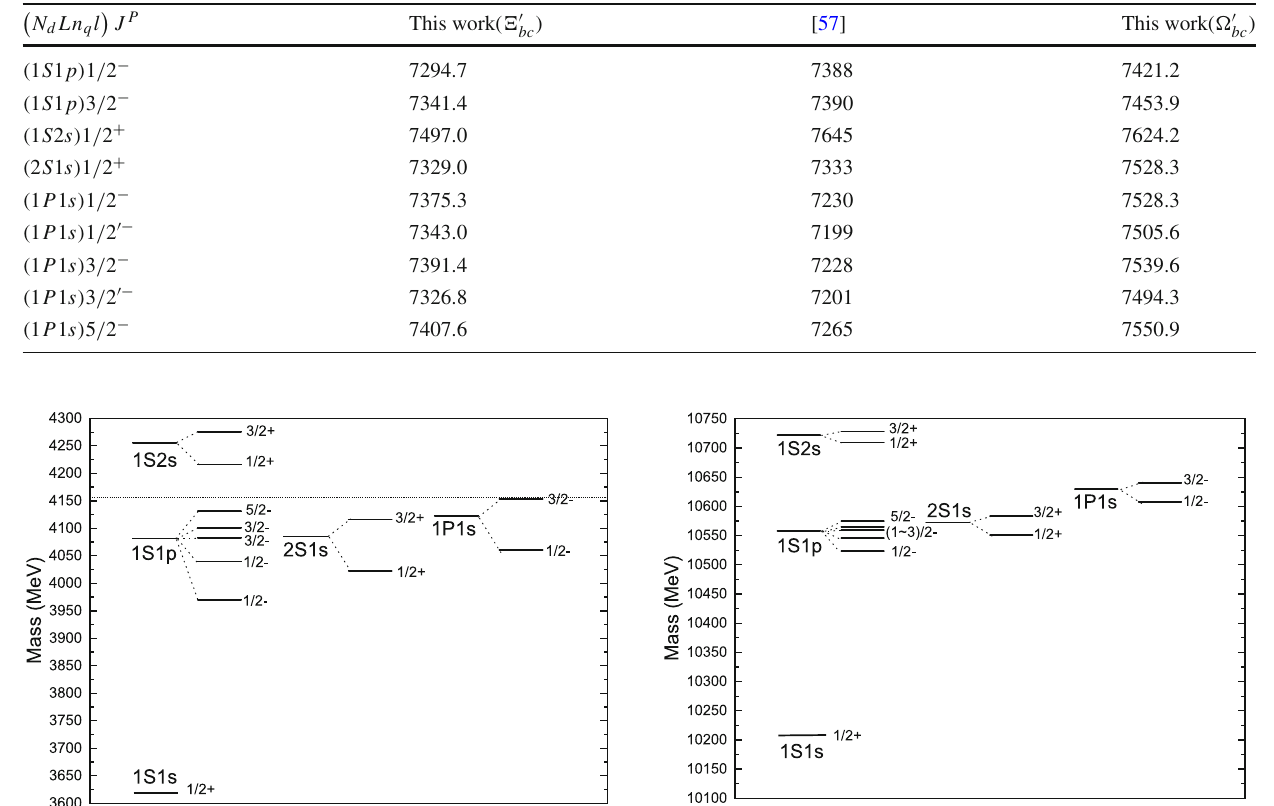
/(cid:3) (cid:2) baryons (in MeV). Our results are obtained by the respective sum of the mean mass of the (cid:2) (cid:2) bc bc